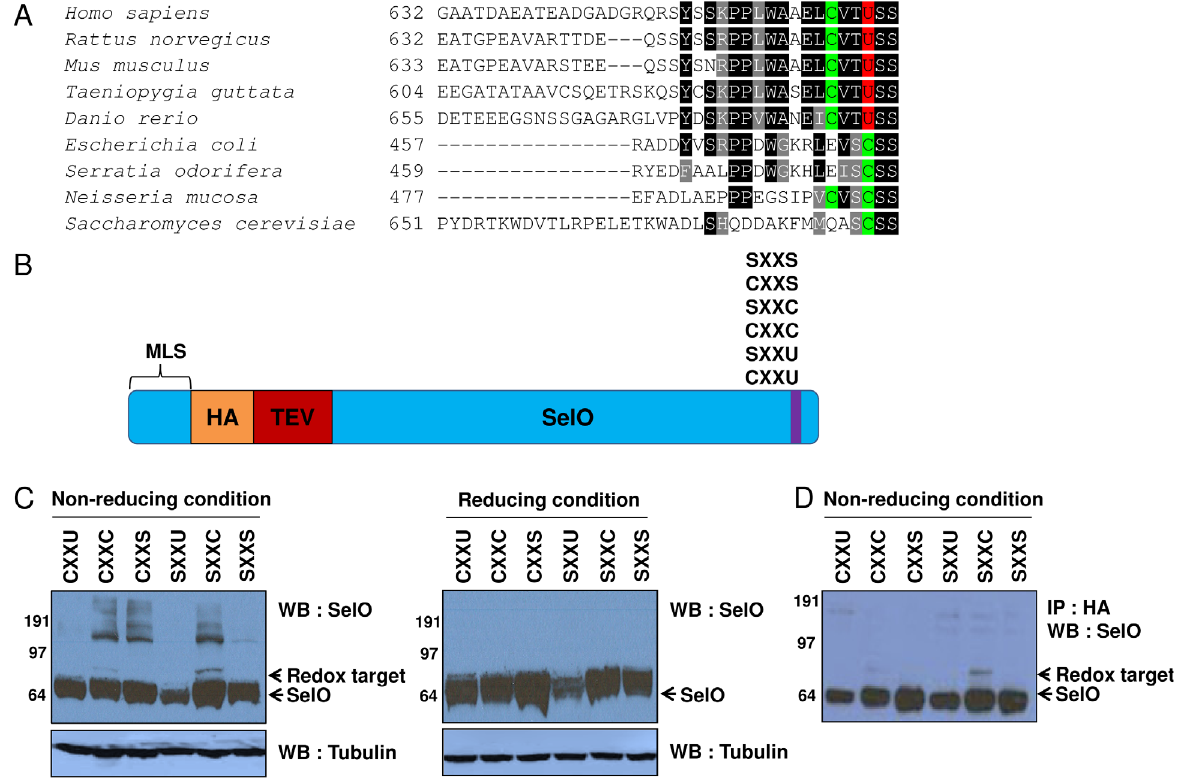
Figure 2. Redox interactions involing human SelO. (A) Protein sequence alignment of the C-terminal region of SelO. (B) Recombinant SelOs. The plasmid construct was designed to trap the interacting partner. The mitochondrial leader sequence (MLS) was flanked by the HA-TEV sequence and the CXXU was changed to SXXU, CXXC, SXXC, CXXS, or SXXS. (C–D) Western blotting of SelO with (C) the cell lysates or (D) the samples that were prepared by using immunoprecipitation with anti-HA antibody from HEK293T cells expressing recombinant human SelO or its mutant forms (CXXU, CXXC, CXXS, SXXU, SXXC, SXXS).